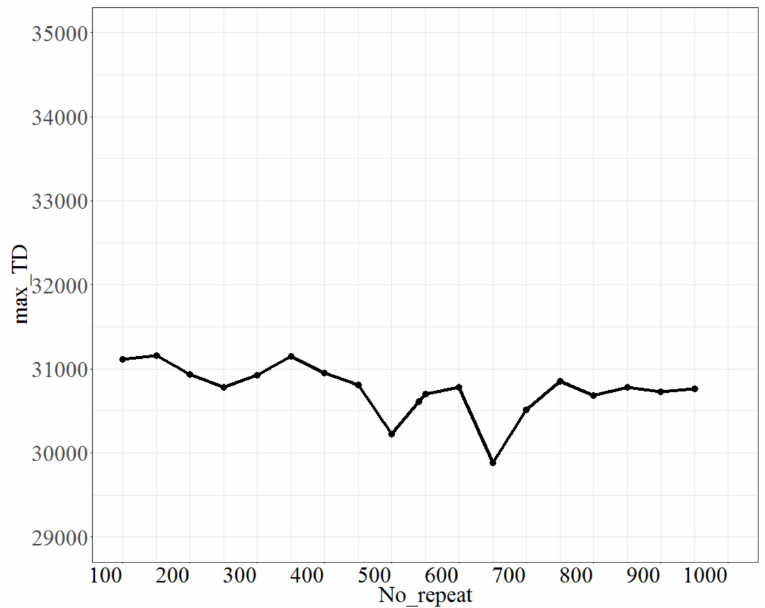
Figure 6. The plot of max_TD as No_repeat varies.